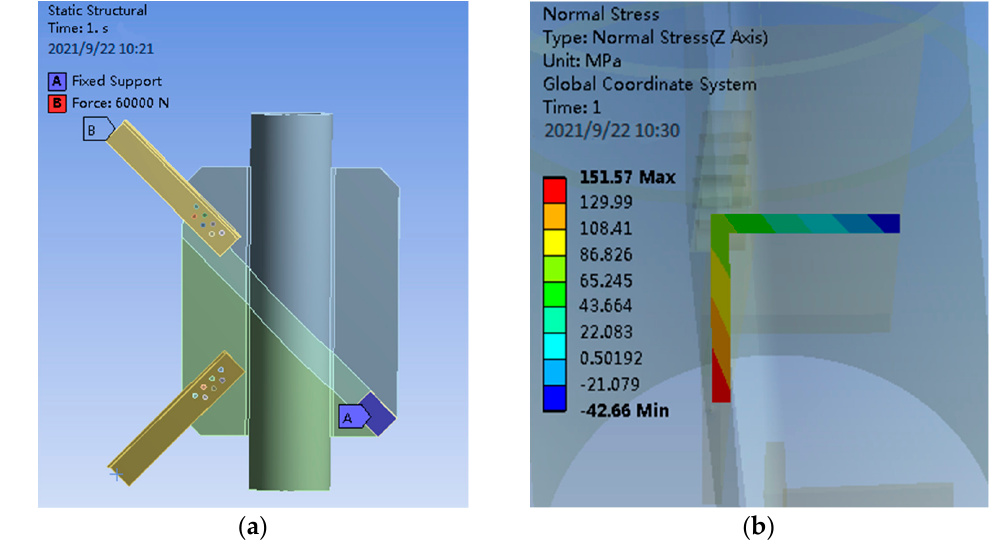
Figure 6. ( a ) Eccentric loading diagram of angle steel for PSLSPJ; ( b ) finite element results of angle steel for